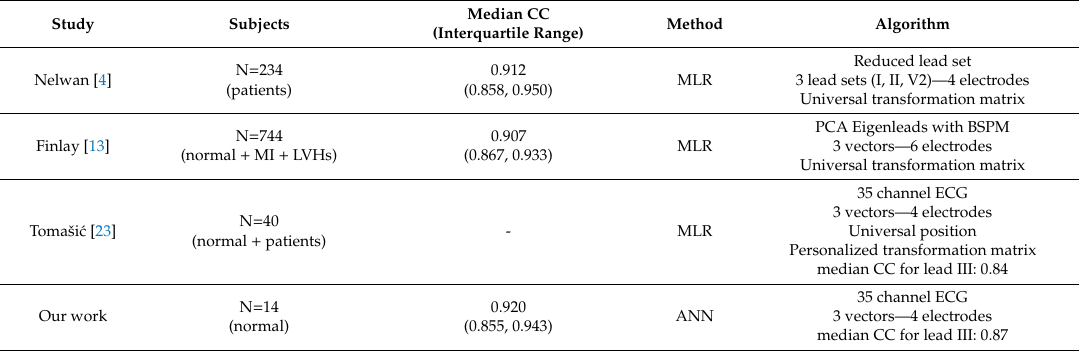
Table 7. Comparisons with previous